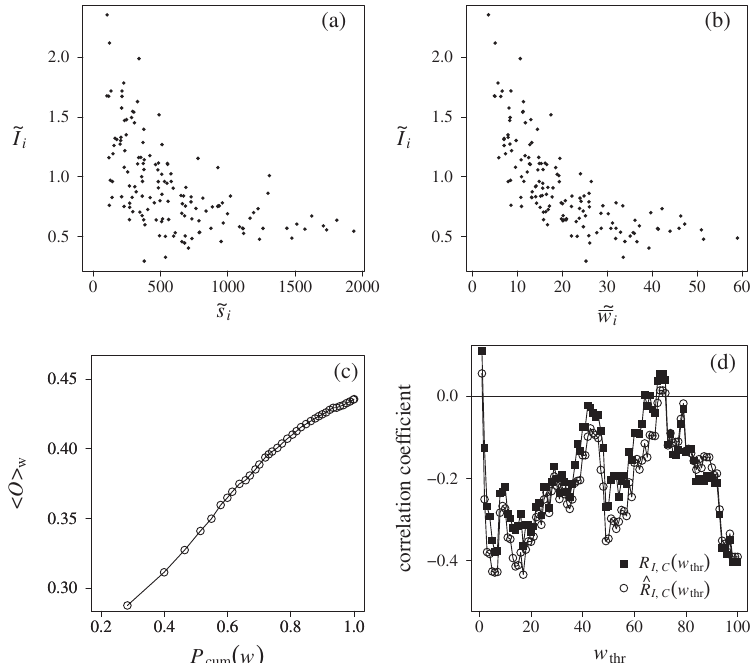
FIG. 17. Results for the interpolated data with m ¼ 1 . We use data set D strength and (b) mean weight. (c) Averaged neighborhood overlap h O i w as a function of the fraction of links with weights smaller than w . (d) Pearson correlation coefficient (squares) and partial correlation coefficient (circles) between I